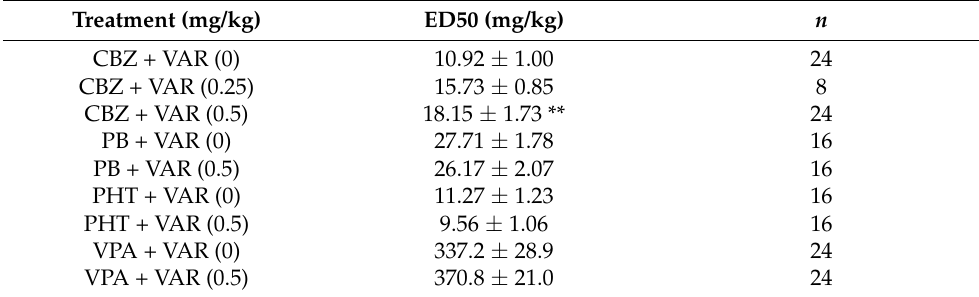
Table 2. Effect of varenicline (VAR) on the protective activity of classic ASMs against MES-induced seizures in mice.